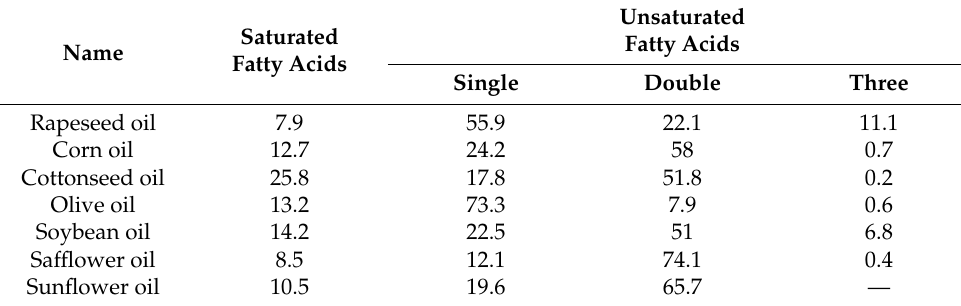
Table 1. Fatty acid component content of common natural ester oil